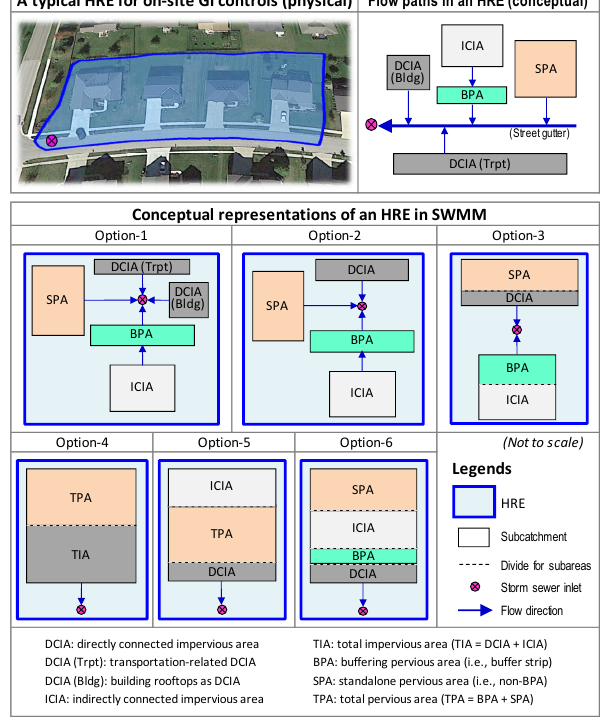
Figure 5. A conceptual representation of the hypothetical HRE (20% DCIA, 30% ICIA, 10% BPA, and 40% SPA) and the six op- tions considered for representing this area in the setup of a SWMM